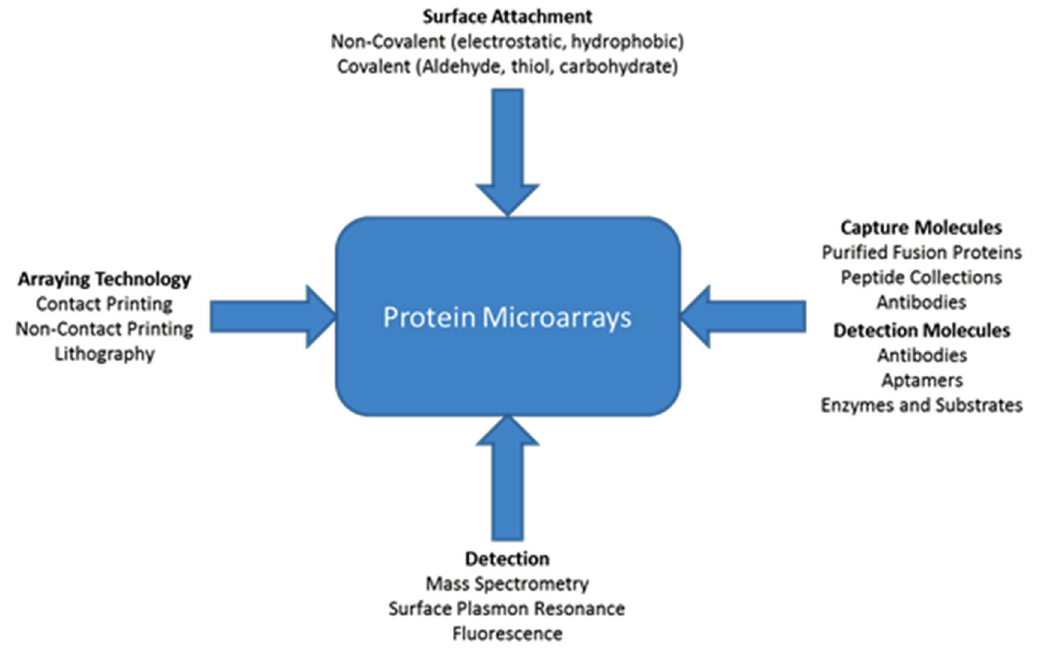
Figure 5. Different technologies for protein